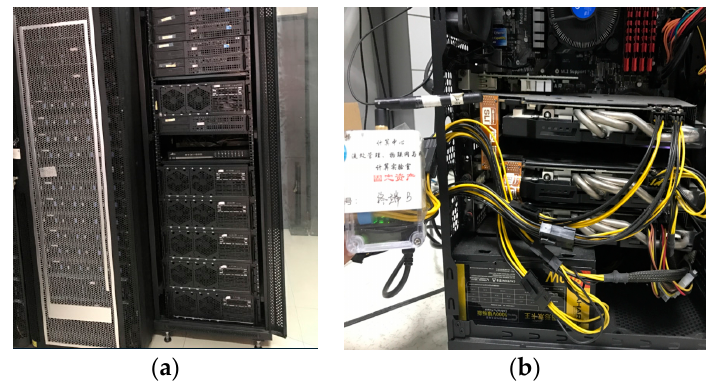
Figure 10. GPU cluster: ( a ) The GTX 280 and 670/680 cluster; ( b ) The GTX 970 cluster. (Note: The